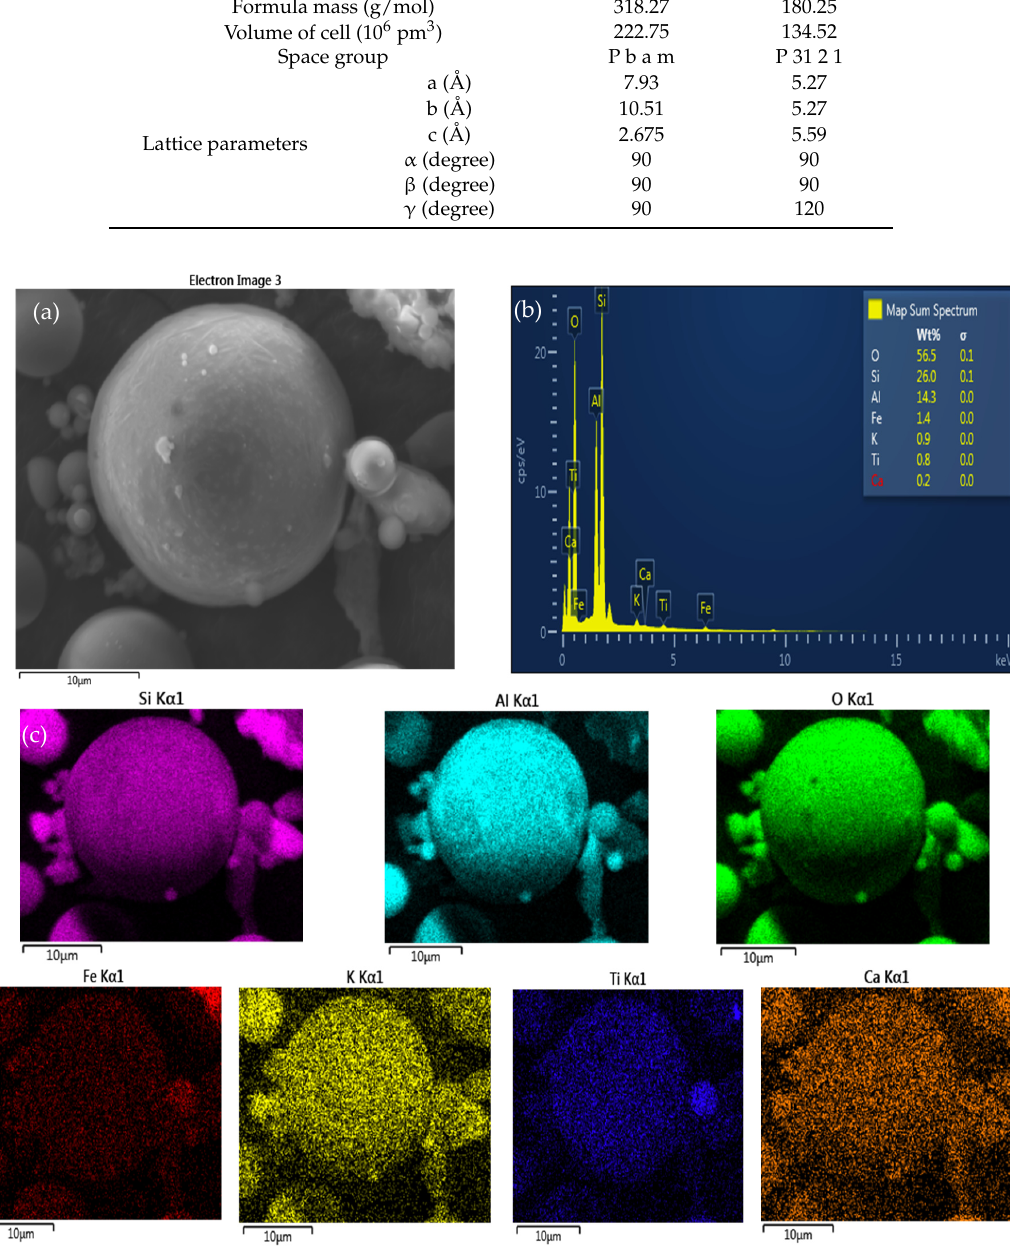
Figure 5. EDS (Energy dispersive X ‐ ray spectroscope) elemental mapping of the raw fly ash powder: ( a ) SEM (Scanning electron microscope) image; ( b ) EDS spectrum of fly ash; and ( c ) corresponding elemental mapping of Si, Al, O, Fe, K, Ti and Ca, respectively.